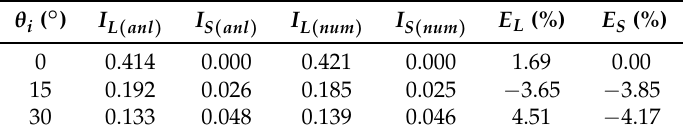
Table 4. Estimated errors ( E L and E S ) between the analytical and numerical calculations of the longitudinal and shear intensity transmission coefficients, I L and I S , for three different incidence